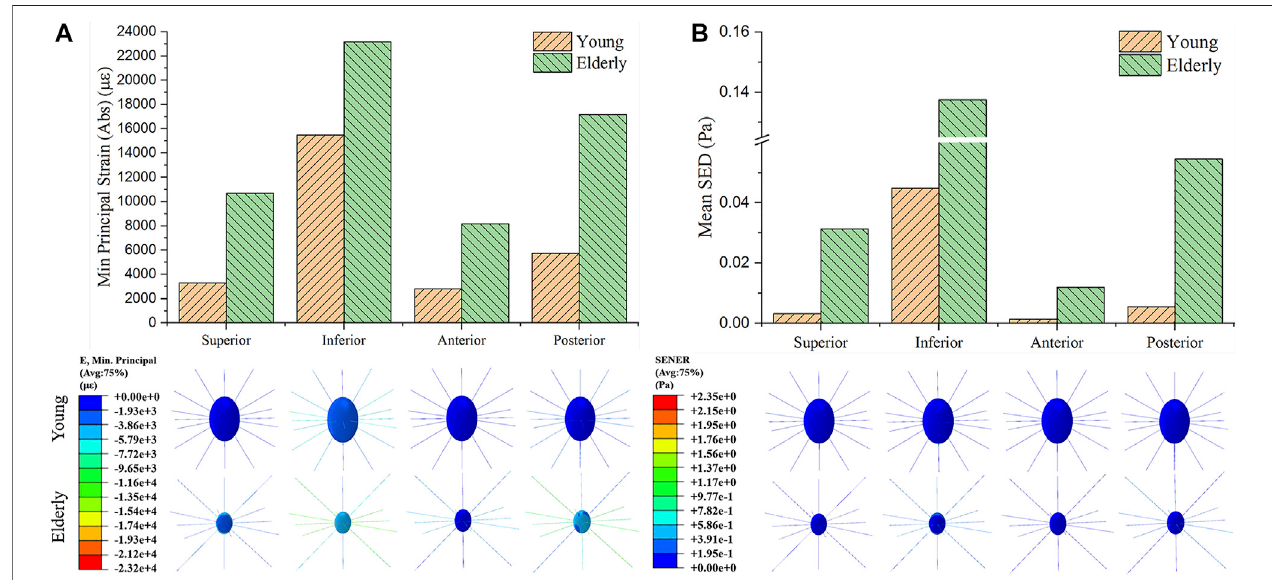
FIGURE 3 | The minimum principal strain (A) and SED (B) of osteocyte in the four quadrants of the mid-femoral neck between the young and the elderly models.